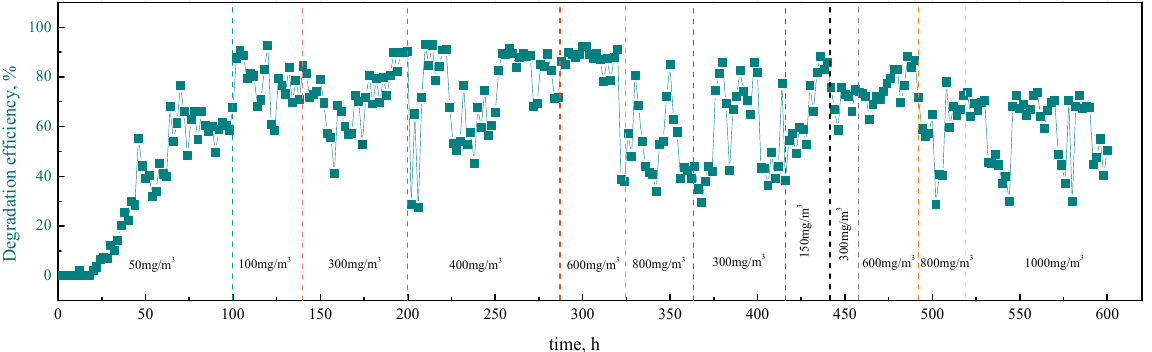
Figure 2. Reduction efficiency of chlorobenzene during biofilm formation. Inlet concentration of chlorobenzene = 50–1000 mg · m − 3 , liquid rate = 5.17 m 3 · m − 2 · h − 1 , EBRT = 96 s, pH = 6.5–7.0, oxygen concentration = 10%. ■ Reduction efficiency of chlorobenzene.